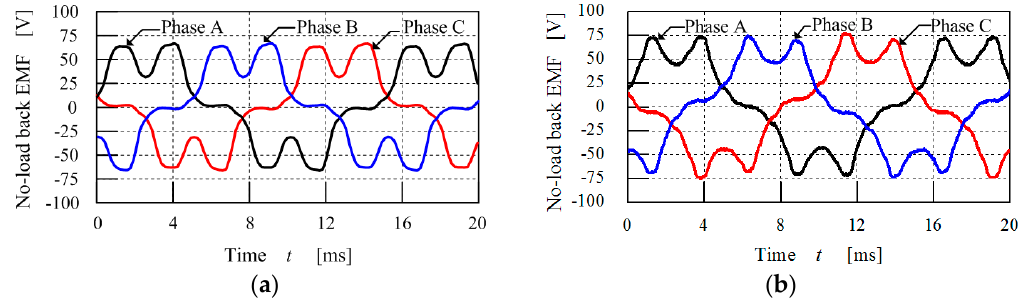
Figure 20. Comparison of no-load back-EMF waveforms at prime rotor speed = 300 rpm: ( a ) Simulated results from finite element analysis; ( b ) Measured results from the experiment.